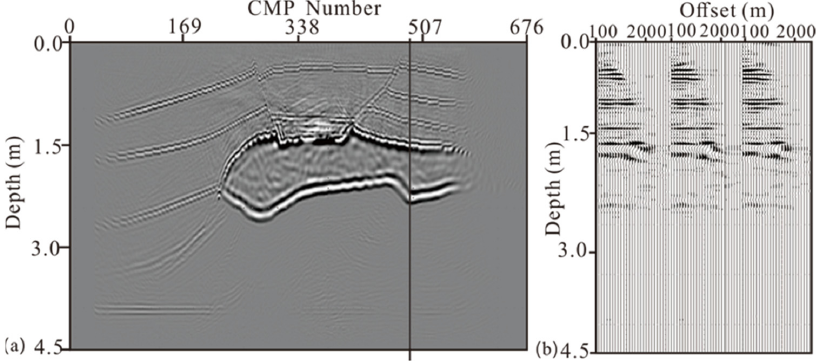
Figure 13. Imaging profile of a subline and three SOGs from the 3D salt model RTM migration. ( a ) is one of subline image, and ( b ) is three SOGs at the black line of ( a ). one of subline image, and ( b ) is three SOGs at the black line of ( a